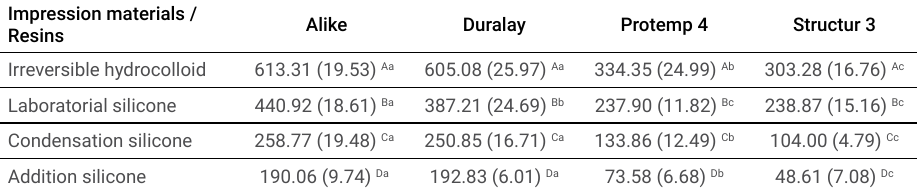
Table 3. Mean (standard deviation) of the marginal discrepancy (μm).